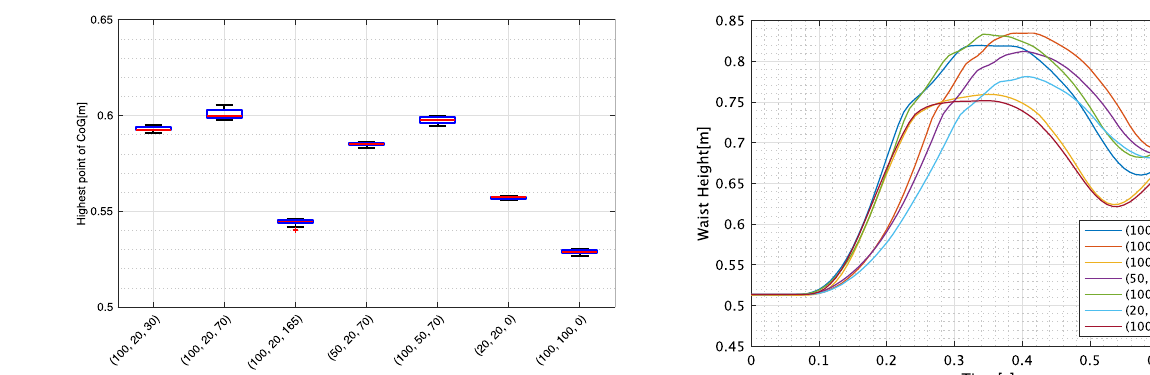
Fig. 15 Variation in waist height with time for each patella. (data for one representative jump out of 15